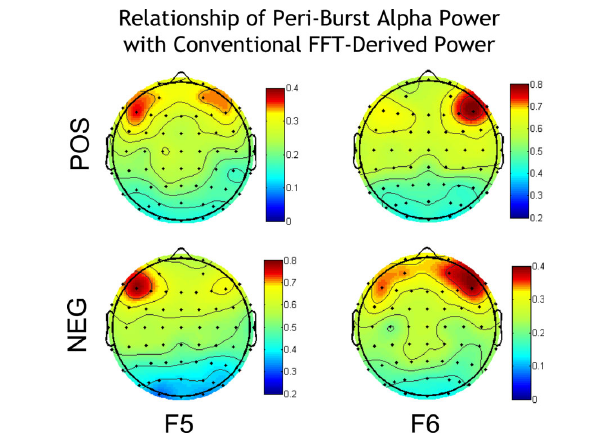
FIGuRE 4 | Correlation of peri-burst alpha power at sites F5 and F6 with the conventional FFT-derived metrics of power over the entire scalp. Correlations are shown separately for positive bursts (top row) and negative bursts (bottom row). All individual site power values (both conventional and peri-burst power) were natural-log transformed prior to correlation, in keeping with the tradition of log-transformed power values in the EEG asymmetry literature. Against the backdrop of modest positive correlations, reflecting global power differences between subjects, there is anatomical specificity such that peri-burst power from F5 correlates most highly with conventional FFT power at F5, and similarly for these metrics at F6. This anatomical specificity is, in part, due to the effective high-pass spatial filter provided by CSD transformation. Note that the range of correlations differs such that positive bursts for F5 and negative bursts for F6 are on a common scale, and negative bursts for F5 and positive bursts for F6 are on a common scale. Maps were constructed by mapping Pearson correlations using the function topoplot from EEGLab (Delorme and Makeig, 2004).